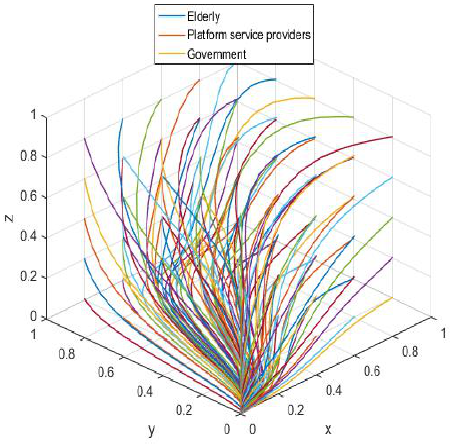
Figure 11. Initial equilibrium state.